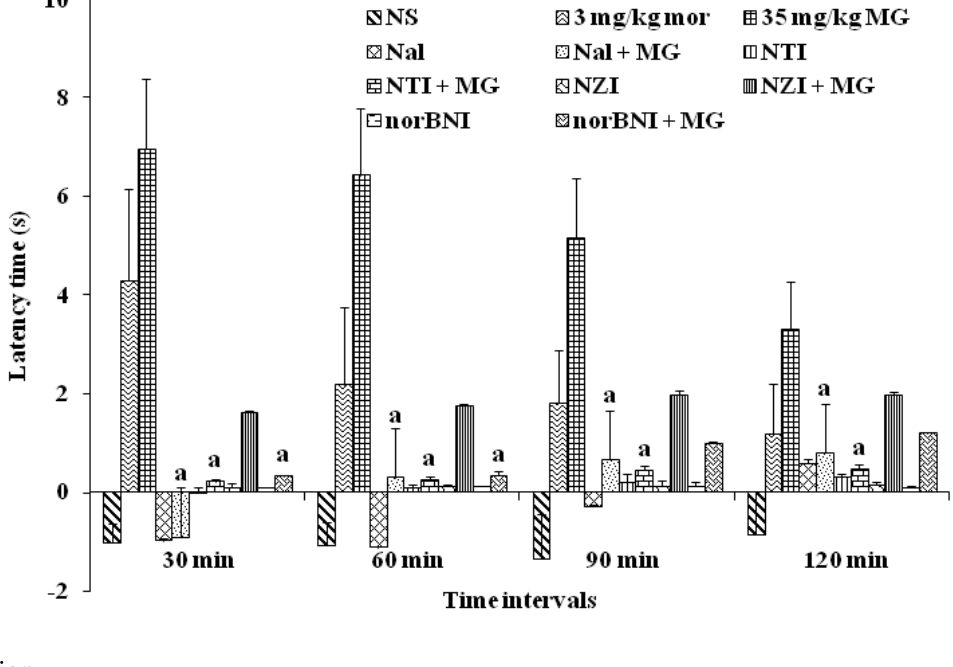
Figure 7. Effects of µ-opioid antagonist naloxone, δ -opioid antagonist naltrindole, µ -opioid antagonist naloxonazine and κ -opioid antagonist norBNI on mitragynine-induced 1 antinociception (35 mg/kg). Each column represents the mean ± SEM of latency time (s) for group of eight animals in each group. Values are statistically significant at p <